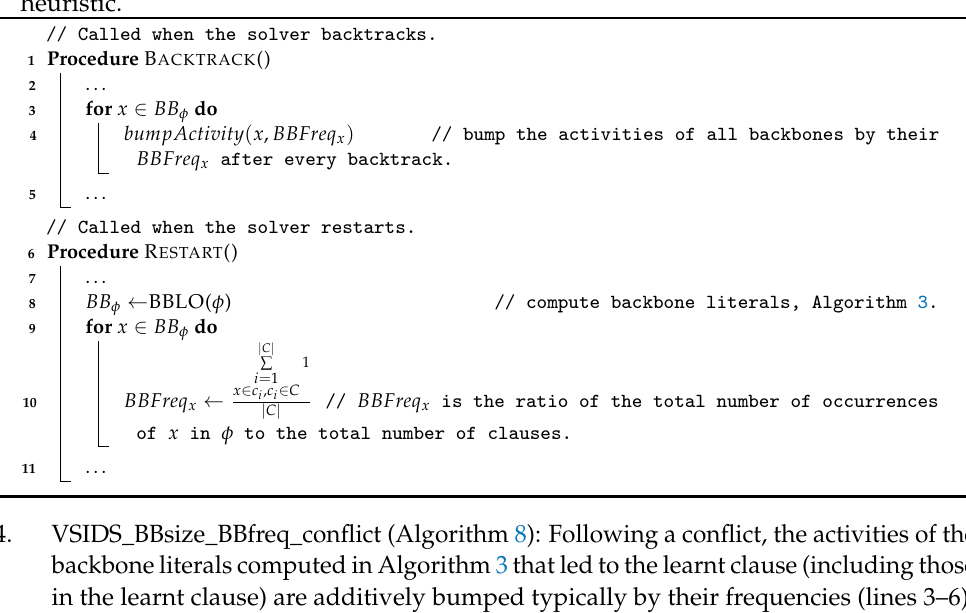
Algorithm 7: VSIDS_BBsize_BBFreq_backtrack a variant of the VSIDS decision